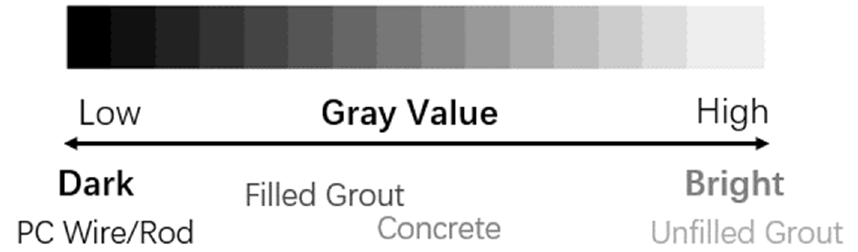
Figure 15. Gray value from low to high and typical materials.